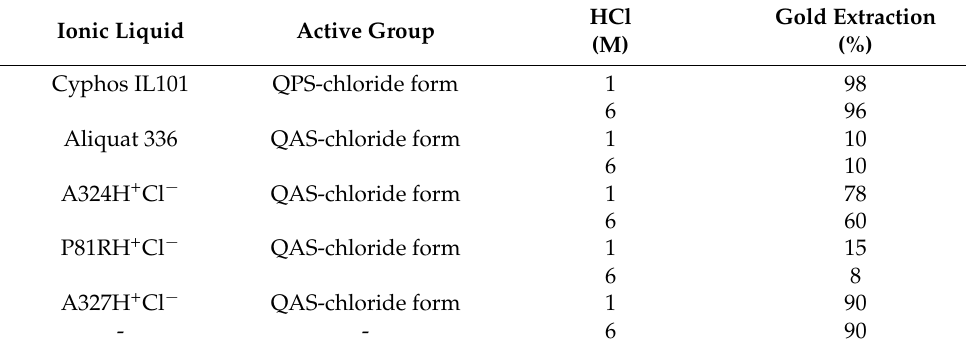
Table 5. Gold extraction using various ionic